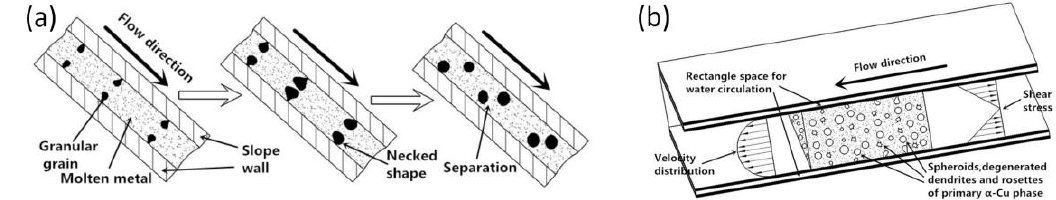
Figure 10. Schematic diagram of: ( a ) the mechanism of neck formation of α -Cu grains; and ( b ) principle of generation of new semi-solid slurry using the ECSC.